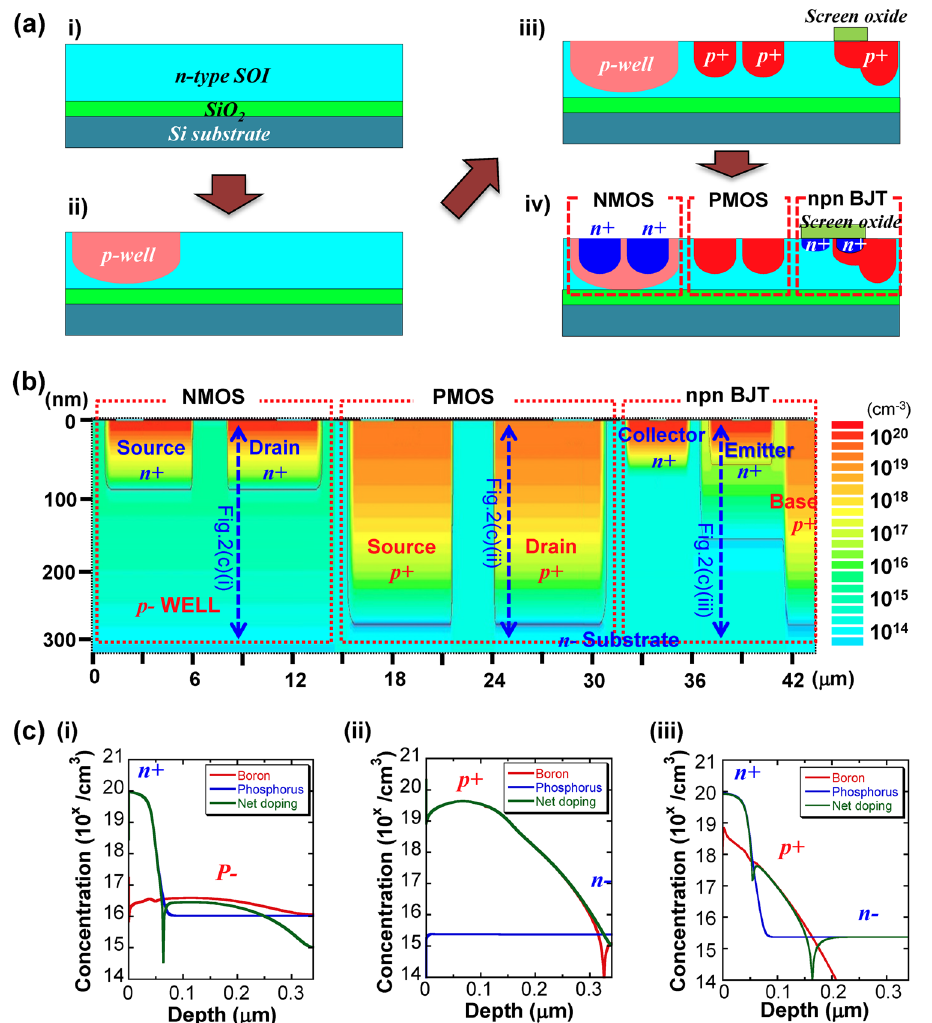
Fig. 2 Illustration of ion implantation processes and their simulations a Process fl ow for ion implantations. i, Preparation of SOI wafer. ii, Formation of a lightly doped p -well for NMOS. iii, Formation of a heavily doped p + regions for the source/drain contacts in PMOS and for the base region in BJT. iv, Formation of a heavily doped n + regions for source/drain contacts in NMOS and emitter/collector regions in BJT. Note that a patterned screen oxide was covering “ the emitter region ” (step iii) or “ the emitter and the collector regions ” (step iv) of BJT in order to reduce the implantation depth. b Simulated doping pro fi les for each type of device formed on the same layer. The simulated ion implantation values (dose and energy) were used to fabricate the actual doped Si NM. c Plots of doping pro fi les in each of the corresponding regions. (i) NMOS ( n + source/drain regions, p-well and the net doping), (ii) PMOS ( p + source/drain regions and substrate), (iii) NPN BJT ( n + emitter, p + base, n -collector and the net